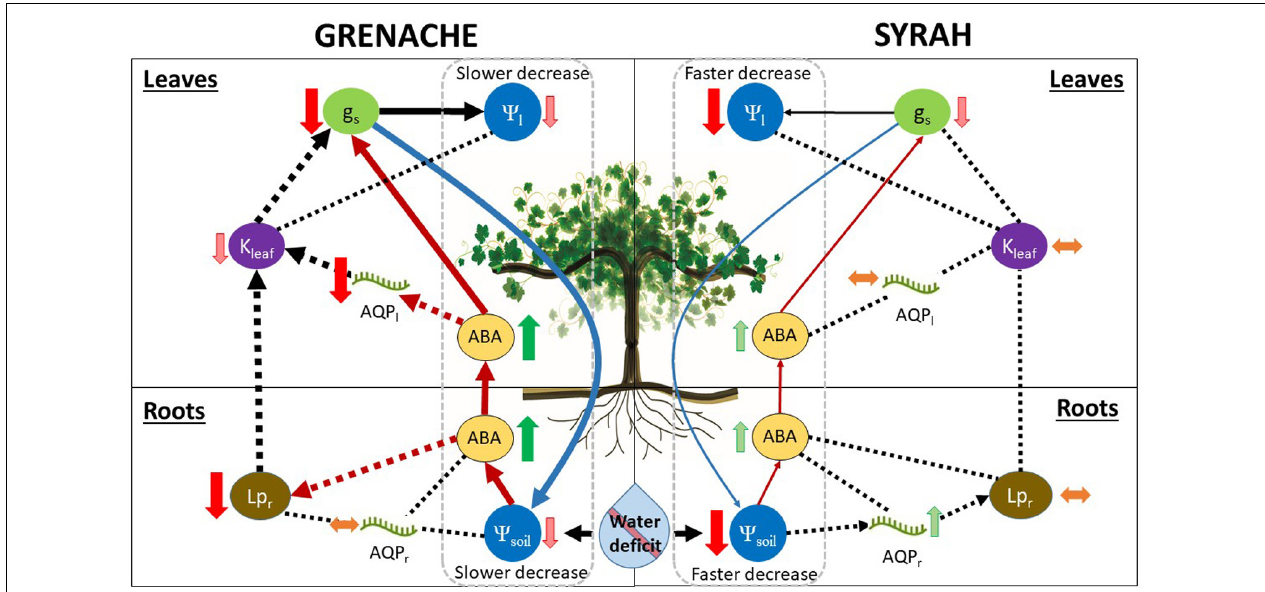
FIGURE 6 | Summary of water deficit effects on water relations of the two grapevine cultivars, Grenache (left side) and Syrah (right side), in this study. Our observations support a model in which Grenache shows a stronger response to water deficit than Syrah through chemical (thick red arrows) and hydraulic pathways (thick black arrows) to limit water loss. In contrast, the cultivar Syrah has a weaker response (i.e., is less sensitive to water deficit than Grenache), which was mainly mediated through less responsive chemical pathway (thin red arrows), leading to greater water loss. Our observations do not support a strict iso-anisohydric distinction between the two cultivars, but rather a hydrodynamic behavior in which strong fluctuations in leaf water potential ( (cid:57) leaf ) are avoided by a tight control of hydraulic pathways. In Grenache, relatively strong control of water loss under water deficit is achieved in the following manner: Even a small decline in soil water potential ( (cid:57) soil ) leads to rapid synthesis of abscisic acid (ABA), causing strong reduction of root hydraulic conductivity ( Lp r ; thick dashed red arrow), as well as downregulation of some AQPs (transcripts) in leaves (AQP l ) and, ultimately, decreased stomatal conductance (g s ) through chemical regulation by ABA (thick red arrows). Our data did not support the hypothesis that (a reduction of) Lp r was transcriptionally regulated by the select root aquaporins (AQP r ) analyzed in this study. Alternative pathways of Lp r regulation are possible that do not directly involve either ABA or AQP r , e.g., root suberisation, xylem embolisms. Additionally to chemical regulation, hydraulic regulation (thick black dashed arrows) may occur as a feed-forward signal, where reductions of Lp r and leaf hydraulic conductance (K leaf ) may induce stomatal closure. Stronger control over stomatal conductance in Grenache would lead to reduced water loss and, therefore, slower decrease of both (cid:57) leaf and (cid:57) soil (thick blue arrow). In Syrah, the control mechanisms for water loss under soil moisture deficit are less responsive than Grenache: Even a larger decline in (cid:57) soil leads to only a small increase in the synthesis of ABA. A reduction in g s appears to be mediated via the chemical pathway (thin red arrows), albeit less significantly compared to Grenache. The increase in ABA had no observable effect on Lp r , K leaf , or select AQP l transcripts. Therefore, control of g s via the hydraulic pathway (thin black dashed arrows) seems less likely. Weaker control of g s in Syrah (compared to Grenache) resulted in greater water loss leading to greater reductions of both (cid:57) leaf and (cid:57) soil (thin blue arrow).